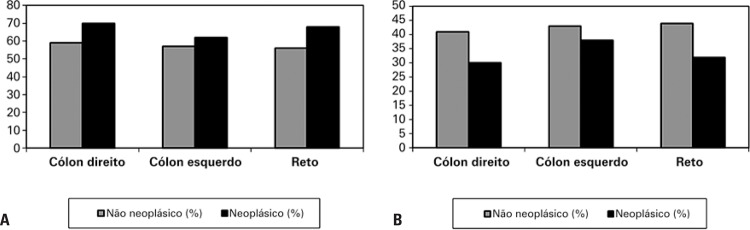
Perfil de glicosaminoglicanos sulfatados em espécimes de tecidos neoplásicos e não neoplásicos de carcinoma colorretal. (A) Galactosaminoglicanos (sulfato de condroitina e sulfato de dermatan) aumentados em tecidos neoplásicos quando comparados a tecidos não neoplásicos (p=0,01). (B) Sulfato de heparan diminuído em tecidos neoplásicos quando comparados a tecidos não neoplásicos